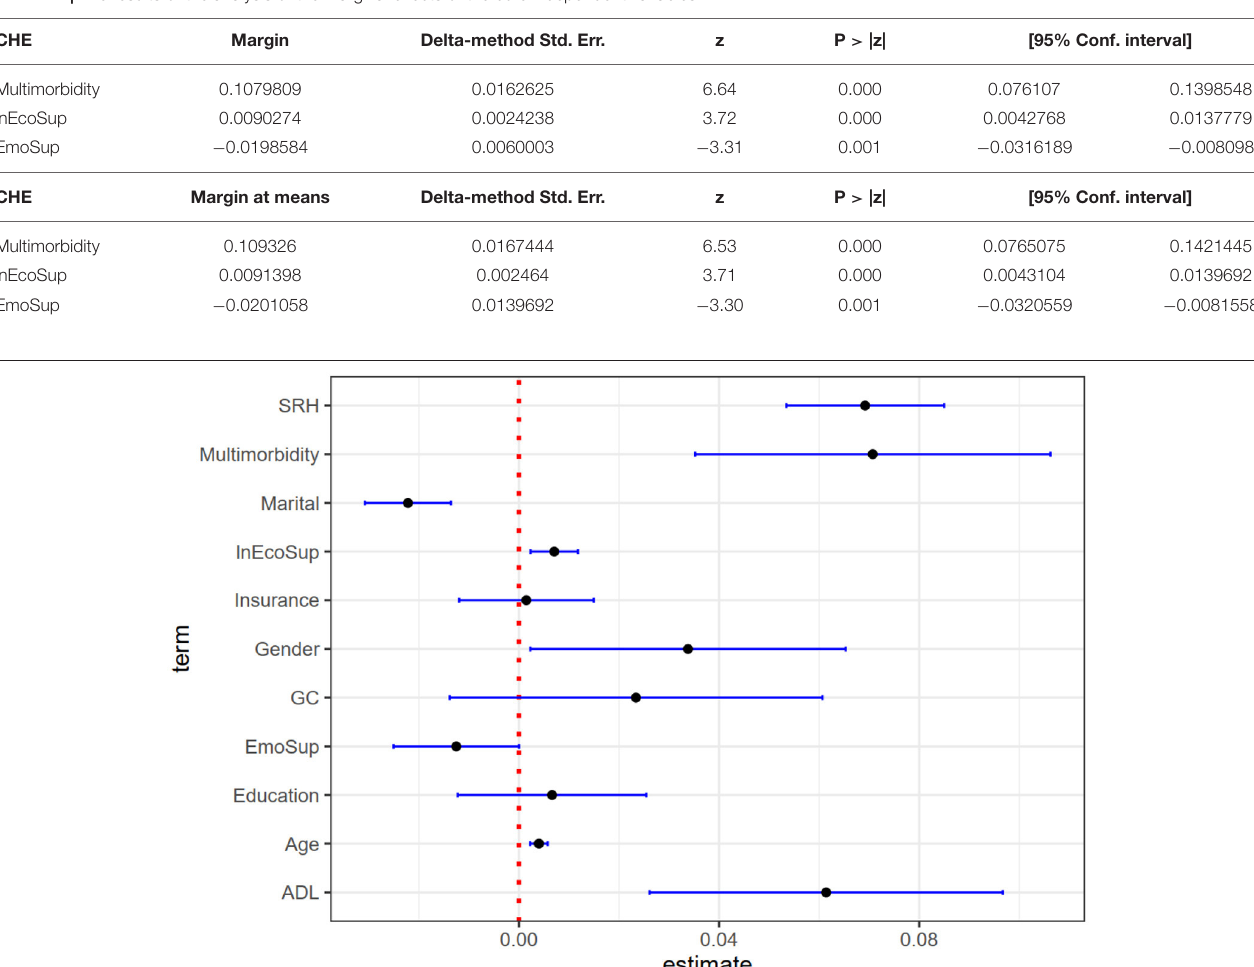
TABLE 4 | The results of the analysis of the marginal effects of the core independent variables. CHE Margin Delta-method Std. Err.